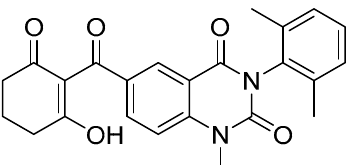
Figure 15. Structure of novel HPPD inhibitor Y13161 (benquitrione).